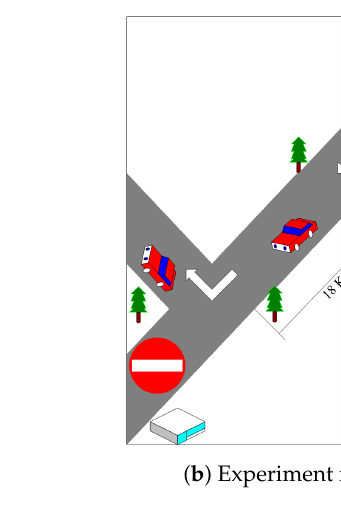
Figure 7. Experimentation